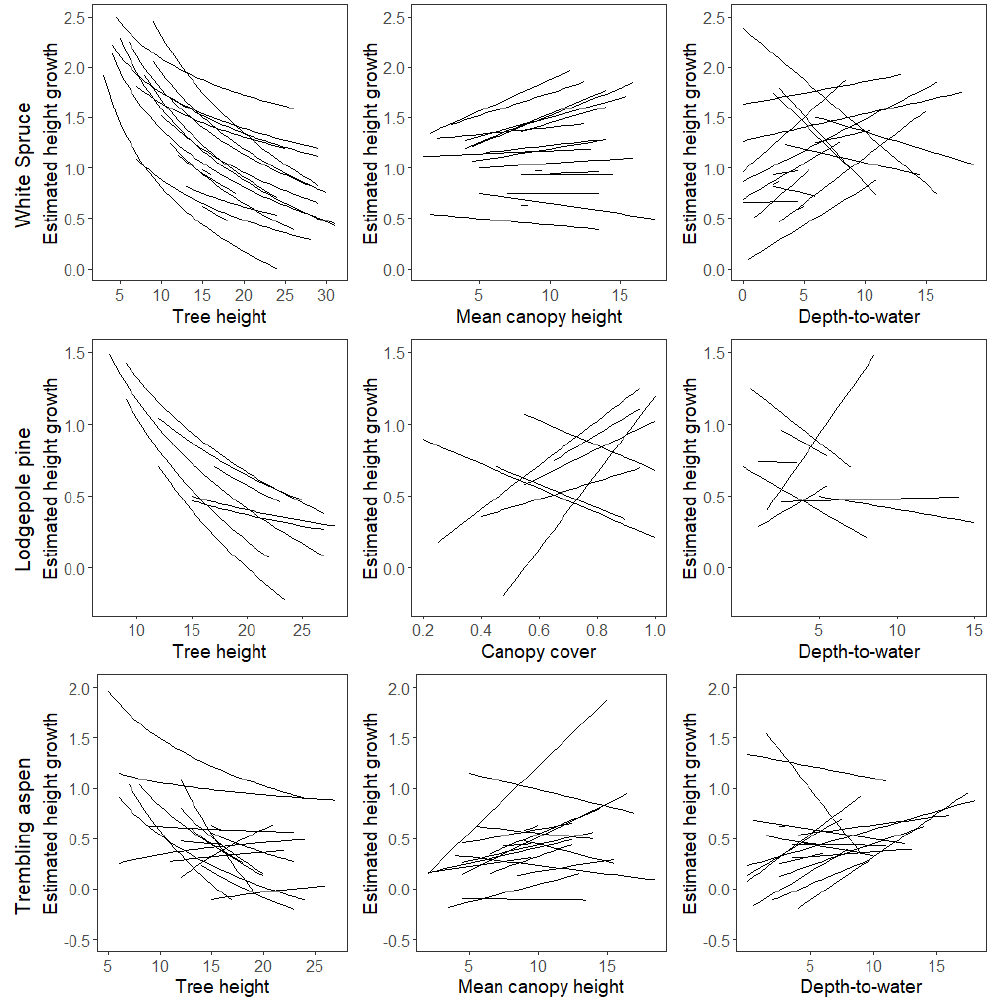
Figure 8. Stand-specific relationships between predicted tree height growth and initial tree height ( left ), neighborhood crowding ( centre ), and depth-to-water ( right ) for each tree species. Note that the axes have different scales across